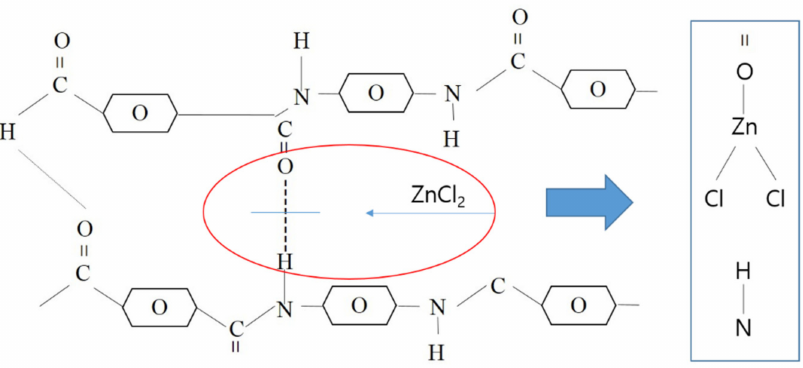
Figure 3. Schematic illustration of hydrogen-bonded sheet structure of Kevlar fiber and ZnCl 2 -Kevlar